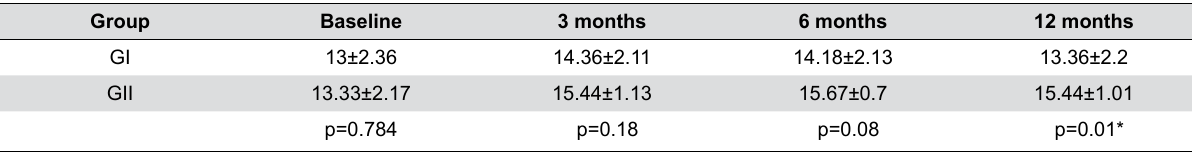
Table 2- Overall patient satisfaction regarding mandibular overdentures supported by one (GI) or two (GII) implants. Comparison between groups (mean±standard deviation)